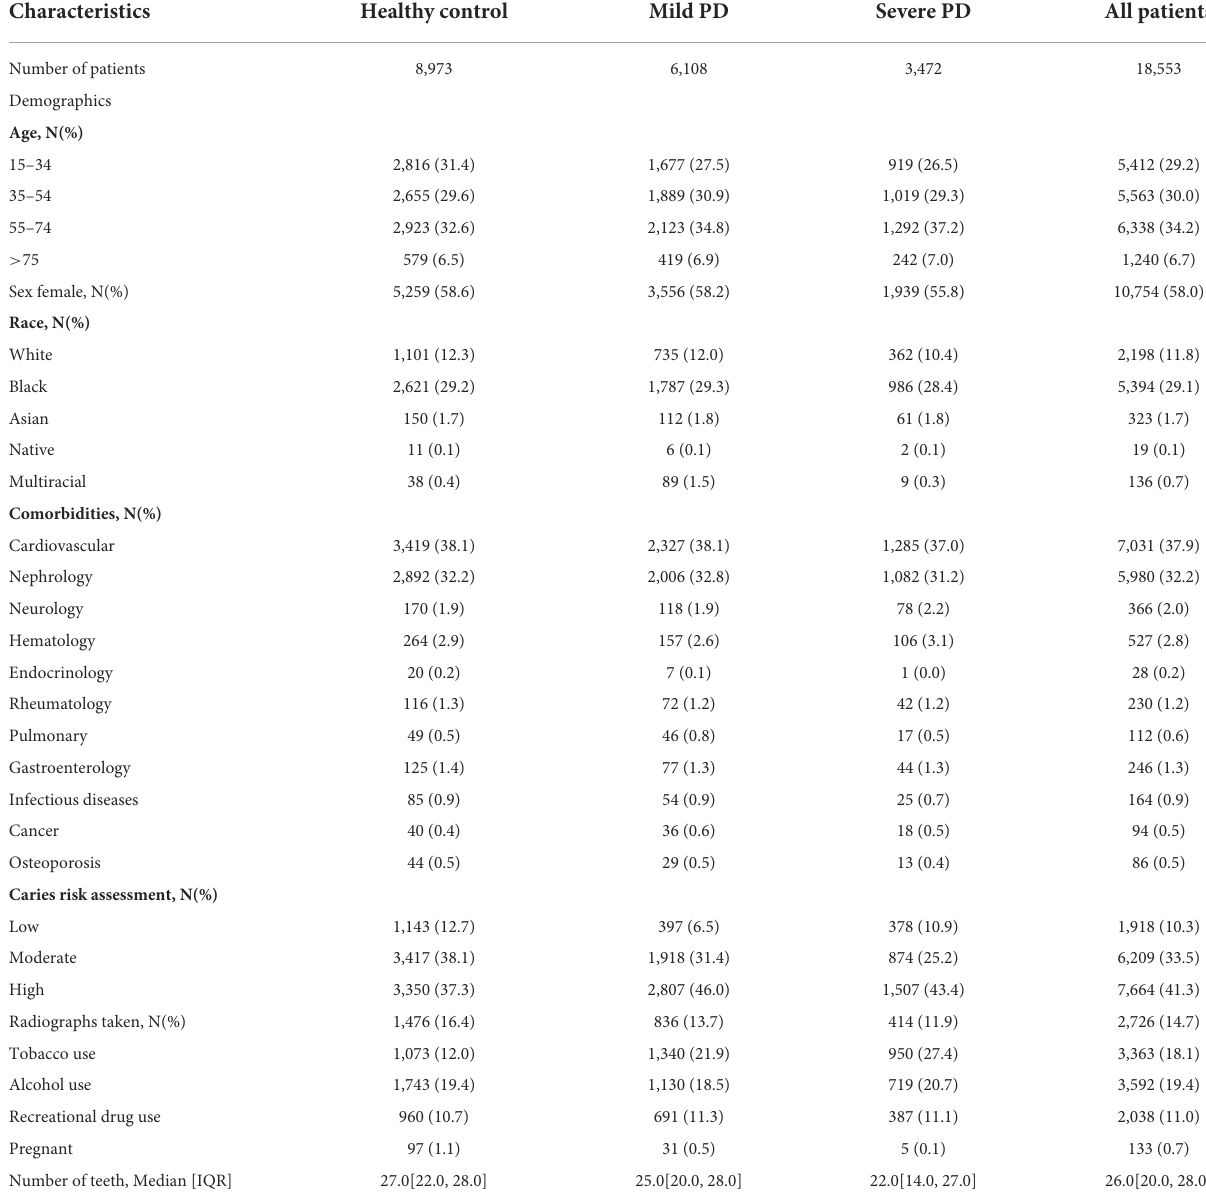
TABLE 1 Characteristics of the studied